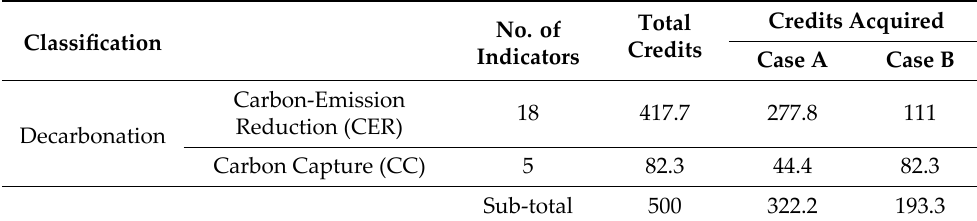
Table 12. Classification of indicators by decarbonation clusters.